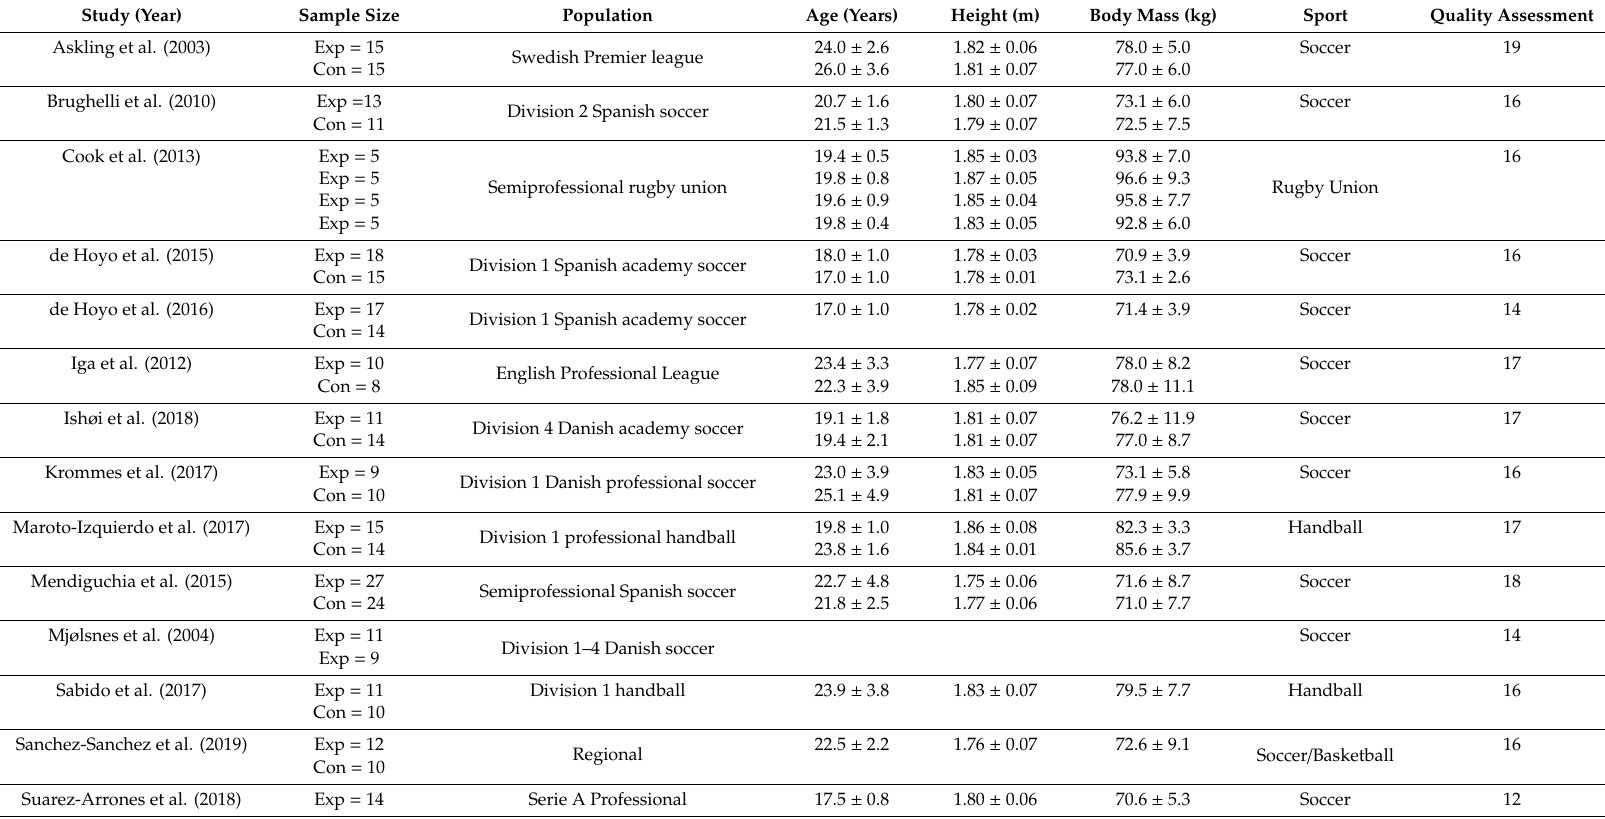
Table 2. Study characteristics for eccentric overload training interventions with male team sport